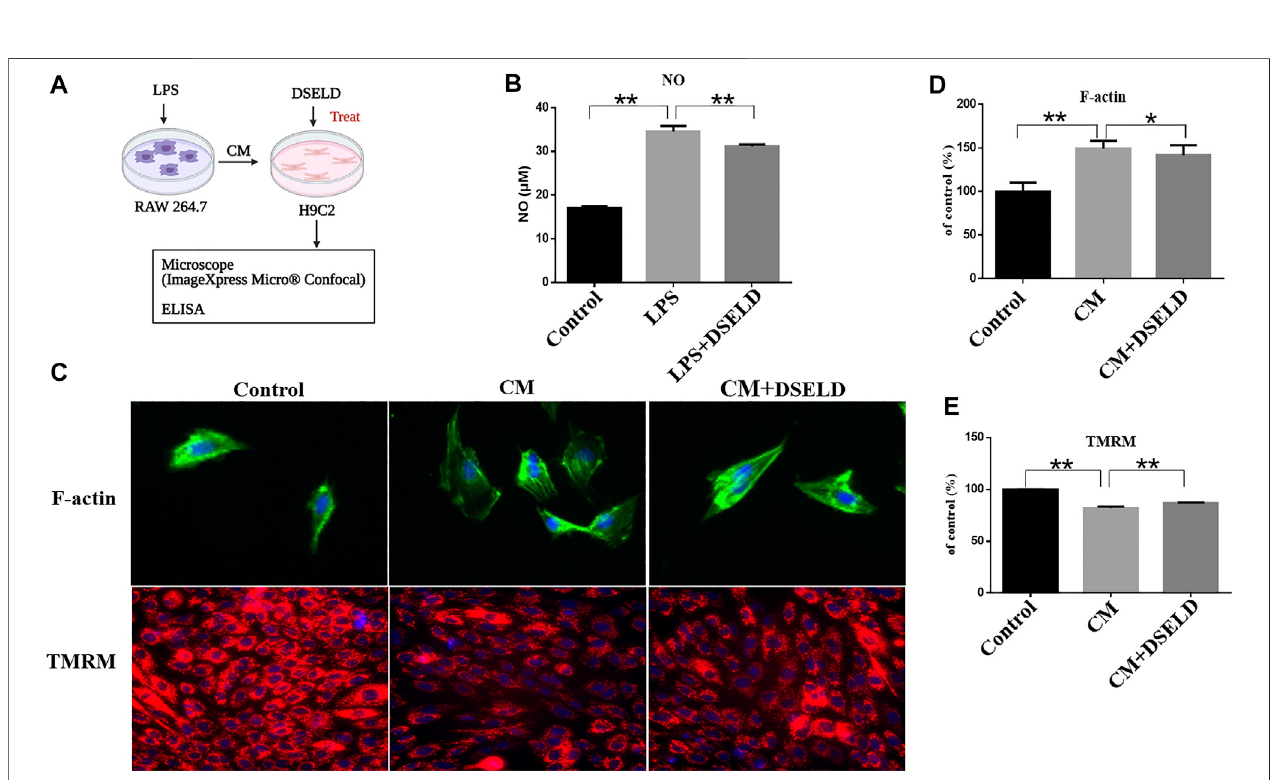
Frontiers in Pharmacology |